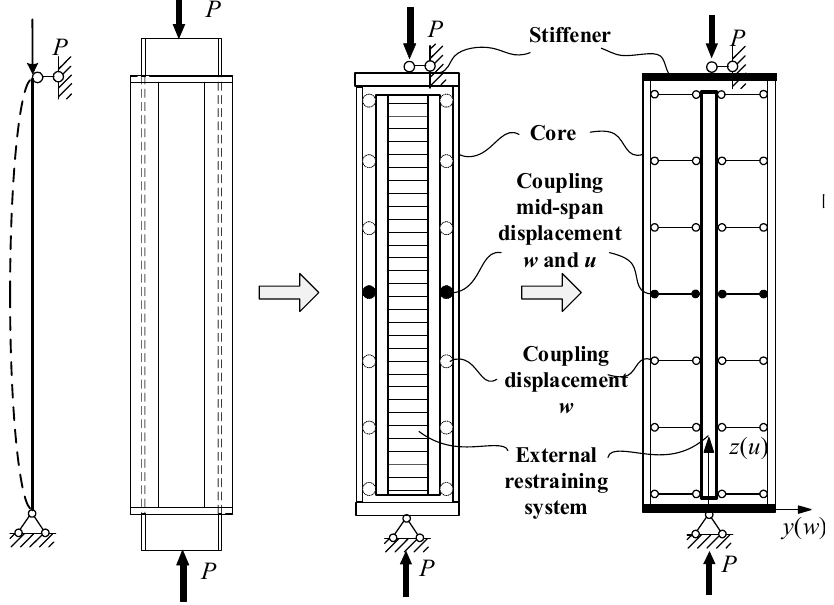
Figure 2. The simplified analytical and calculation model of a